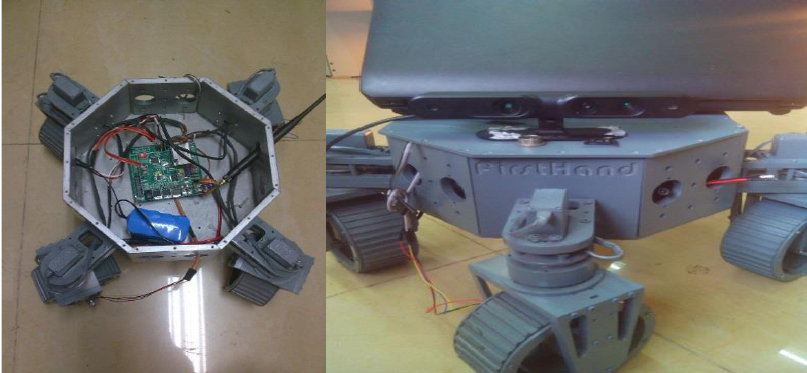
Figure 3. Kinect and experimental platform WX-DP203. Table 1. Control point coordinates (in meters).